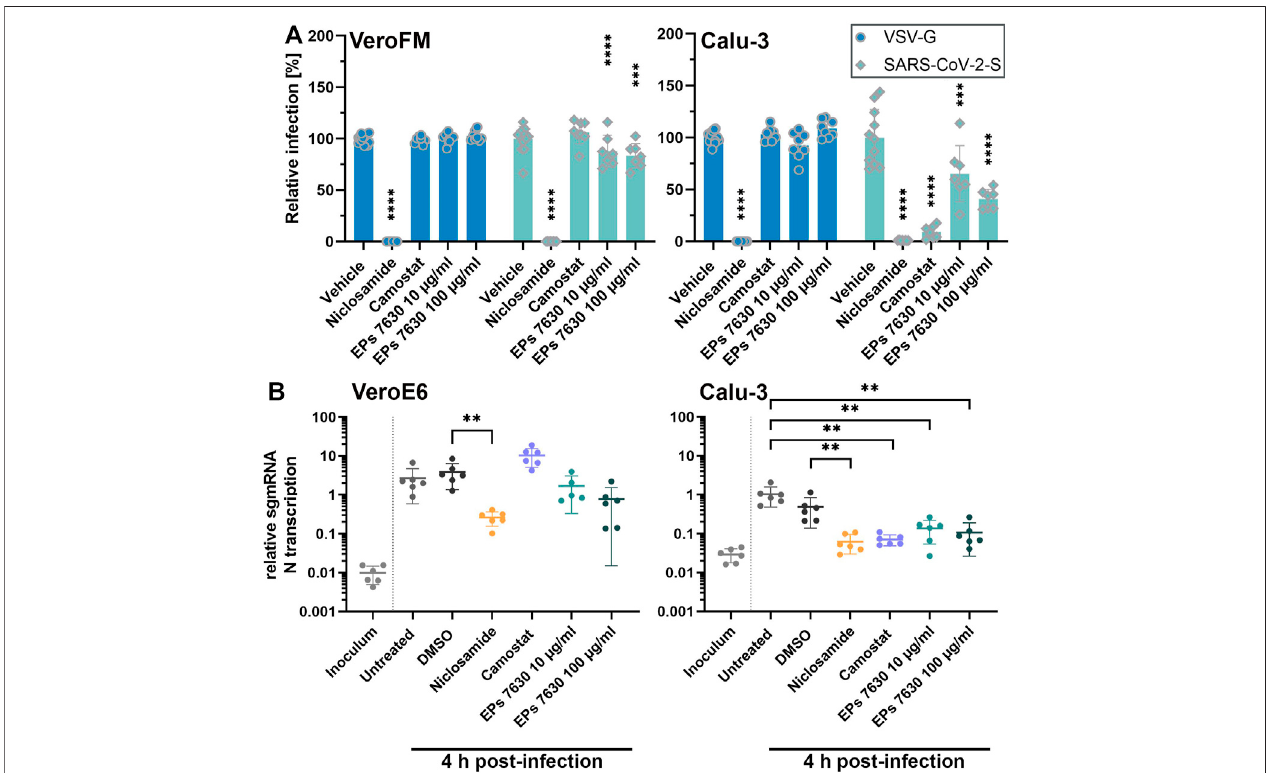
FIGURE 2 | EPs 7630 inhibits entry of VSVpp-SARS-CoV-2-S and SARS-CoV-2 in TMPRSS2-negative VeroFM and TMPRSS2-positive Calu-3 cells. Cells were pre-treated with the indicated compounds for 2 h pre-infection at 37 ° C. (A) Infection with luciferase-producing VSVpp-SARS-CoV-2-Spike (SARS-CoV-2-S), VSV-G control, or pCG1 vector control was done in the presence of compounds for 30 min at 4 ° C at 300 × g followed by 1.5 h incubation at 37 ° C to achieve synchronous infection.Themediumwasthenreplacedbycompound-containingDMEMasindicated.Ascontrols,weapplied10 μ Mniclosamide(endosomalentryblocker)and 10 μ Mcamostatmesylate(TMPRSS2inhibitor).Celllysateswerepreparedafter16h(VeroFM)or24h(Calu-3)andluminescencewasmeasuredusingamulti-mode96- well plate reader. Bars represent mean values and SD from at least n (cid:2) 7 biological samples from two independent experiments. Vehicle (cid:2) DMSO-(niclosamide) or medium (remaining compounds). Statistical signi fi cance (treatment vs. control) is indicated by (*) asdetermined bytwo-way ANOVA with Dunnett ’ smultiple comparison testing. (*) (cid:2) p < 0.05; (**) (cid:2) p < 0.01; (***) (cid:2) p < 0.001; (****) (cid:2) p < 0.0001. (B) VeroE6 and Calu-3 cells were pretreated with the indicated compound 2 h as described in (A) .Infection withSARS-CoV-2(MOI (cid:2) 1)wasdonebyincubationfor15minat4 ° C,followedby30minat37 ° Ctoachievesynchronized infection.Themediumwasthen replacedbycompound-containingDMEMasindicated.Ascontrols,weapplied10 μ Mniclosamide(endosomalentryblocker)and10 μ Mcamostatmesylate(TMPRSS2